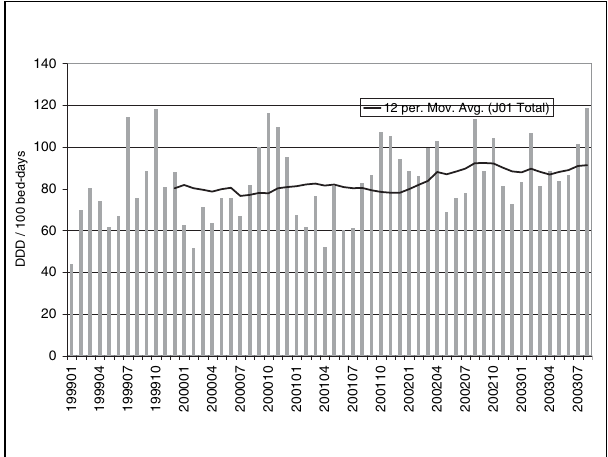
Figure 7) J01 antibiotic use in the Health Sciences Centre’s surgery service from January 1999 to August 2003 in monthly measurements. DDD Defined Daily Dose; Mov Avg Moving